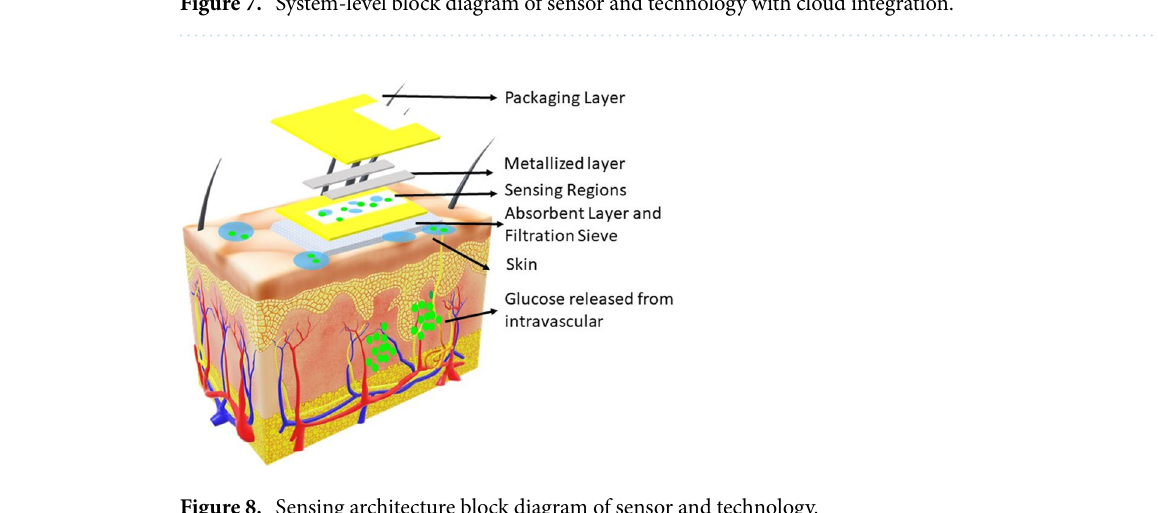
Figure 7. System-level block diagram of sensor and technology with cloud integration.